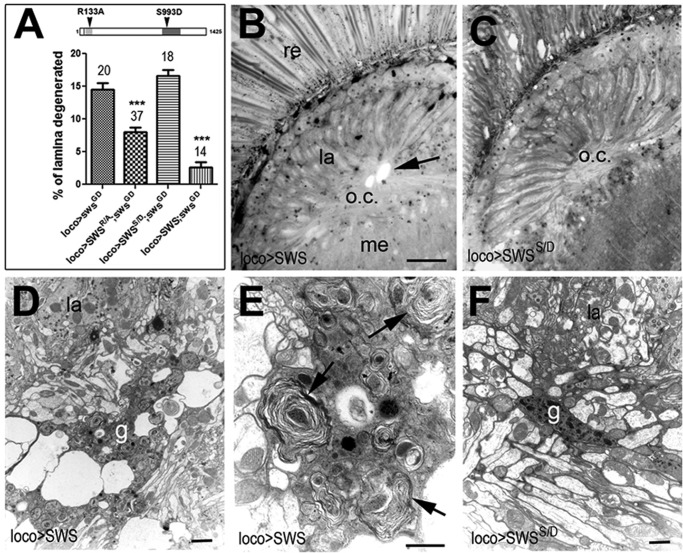
The phospholipase domain is required for glial function. (A) Expression of the SWS construct mutated in the PKA-C3 binding site (SWSR/A) and wild-type SWS significantly reduce the vacuolization in the lamina cortex of 14-day-old loco-GAL4;swsGD flies. In contrast, expression of the construct mutated in the phospholipase domain (SWSS/D) does not rescue the phenotype. Number of tested flies and s.e.m. are indicated. ***P<0.001. (B,C) Expression of SWS via loco-GAL4 in wild-type flies causes vacuole formation at the first optic chiasm (o.c., arrow), whereas SWSS/D expression via loco-GAL4 does not (C). Both flies were 14 days old. (D,E) Analyzing 14-day-old loco-GAL4;UAS-SWS flies at the electron microscopic level showed changes in the chiasma glia at the first optic chiasm (D), with multiple membranous whorls and vesicles accumulating in the glial cytoplasm (arrows, E). (F) When inducing SWSS/D with loco-GAL4, the chiasma glia (g) is indistinguishable from wild type at 14 days. Scale bars in B,C: 12 µm, in D: 2 µm, in E,F: 1 µm. re, retina; la, lamina; me, medulla.